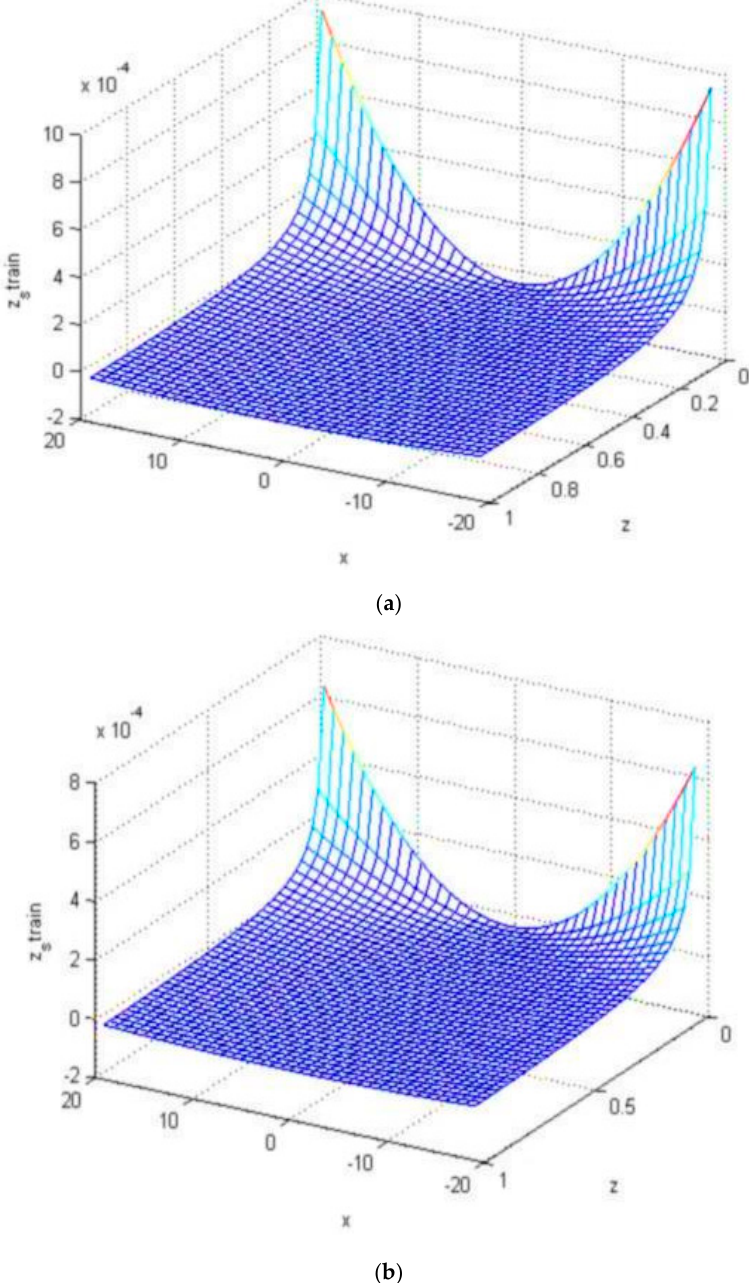
Figure 15. Longitudinal strain of the microstructure with unequal surface curvature radius. ( a ) Comprehensive strain (radius: 25 mm); ( b ) comprehensive strain (radius: 30 mm).